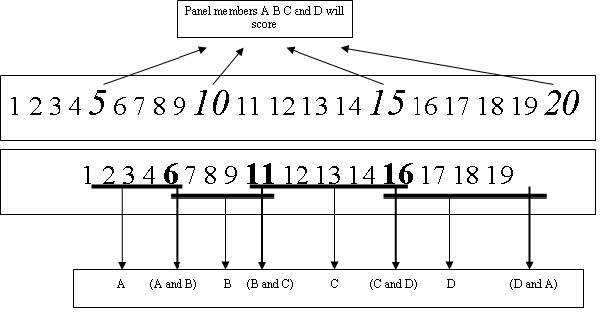
Allocation of medical records for expert panel assessment consisting of four raters. All panel members rated 25% of cases and two raters (six possible pairs) rated an additional 20% of cases.